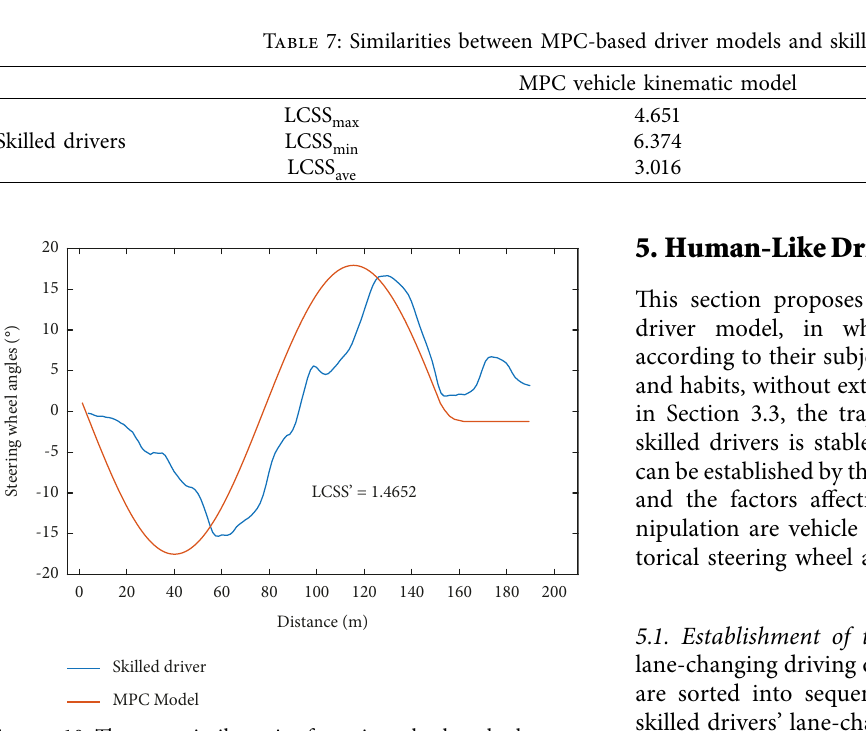
Figure 10: The most similar pair of steering wheel angles between the MPC-based model and skilled drivers.